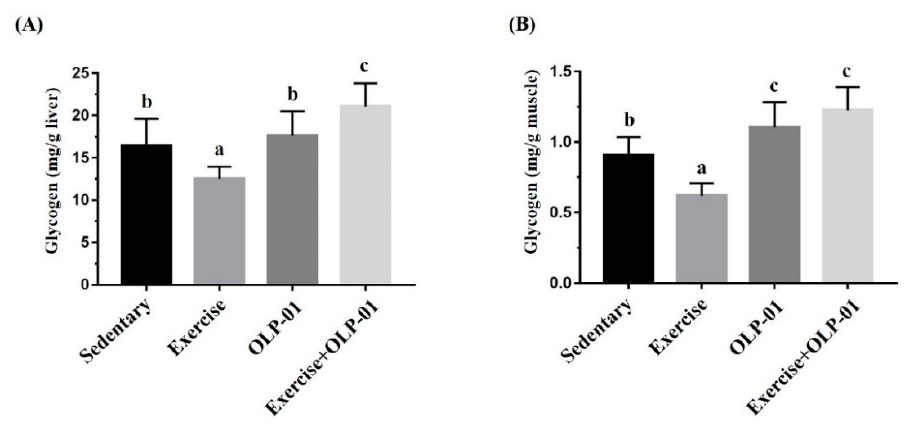
Figure 6. Effects of six weeks of exercise and probiotic interventions on liver ( A ) and muscle ( B ) glycogen contents. The four groups underwent 90 min of swimming exercise, and blood was sampled after 60 min of rest. Data are represented as the mean ± SD, and columns with different letters (a, b, c) were significantly different at p < 0.05.